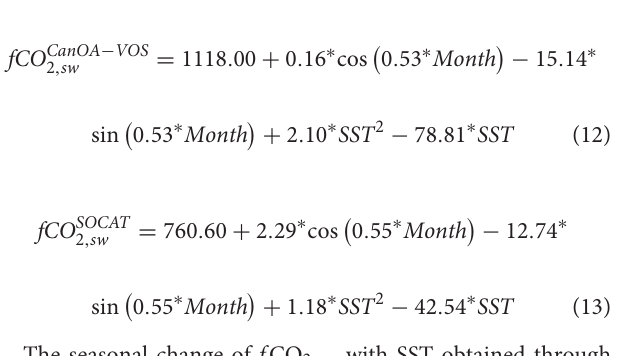
= 1118 . 00 + 0 . 16 ∗ cos (cid:0) 0 . 53 ∗ Month (cid:1) − 15 . 14 ∗ fCO CanOA − VOS 2 , sw (cid:0) (cid:1) + sin 0 . 53 ∗ Month 2 . 10 ∗ SST 2 − 78 . 81 ∗ SST